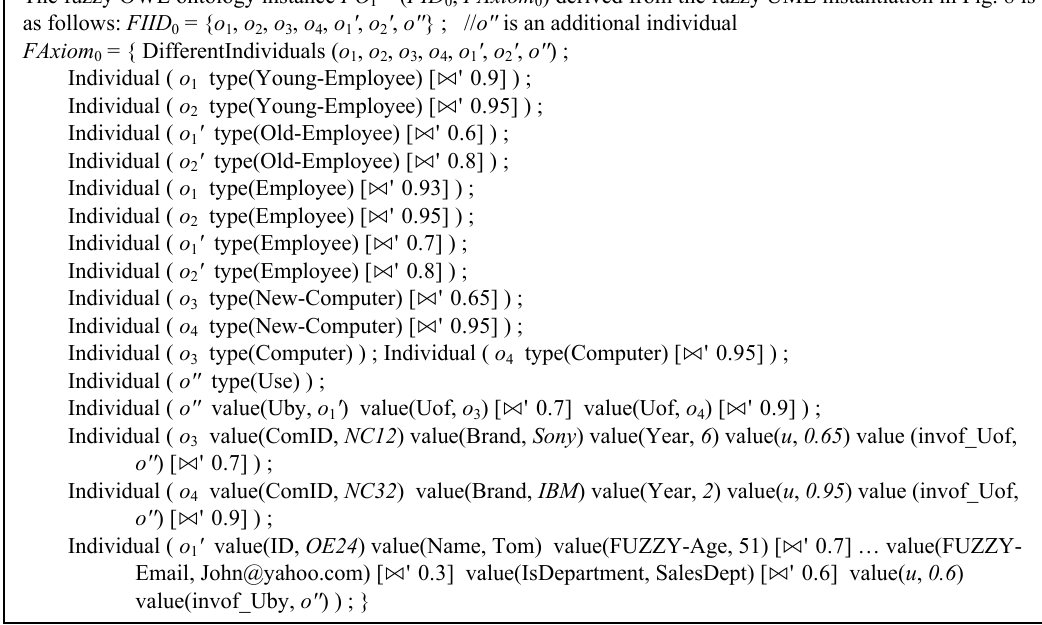
the transformed fuzzy ontology instance (w.r.t. the fuzzy ontology structure in Fig. 9) is shown in Fig. 10. Fig. 8 (w.r.t. the fuzzy UML model in Fig. 6 and Fig. 7), in Fig. 10 form a target fuzzy ontology. The fuzzy OWL ontology instance FO I = ( FID 0 , FAxiom 0 ) derived from the fuzzy UML instantiation in Fig. 8 is